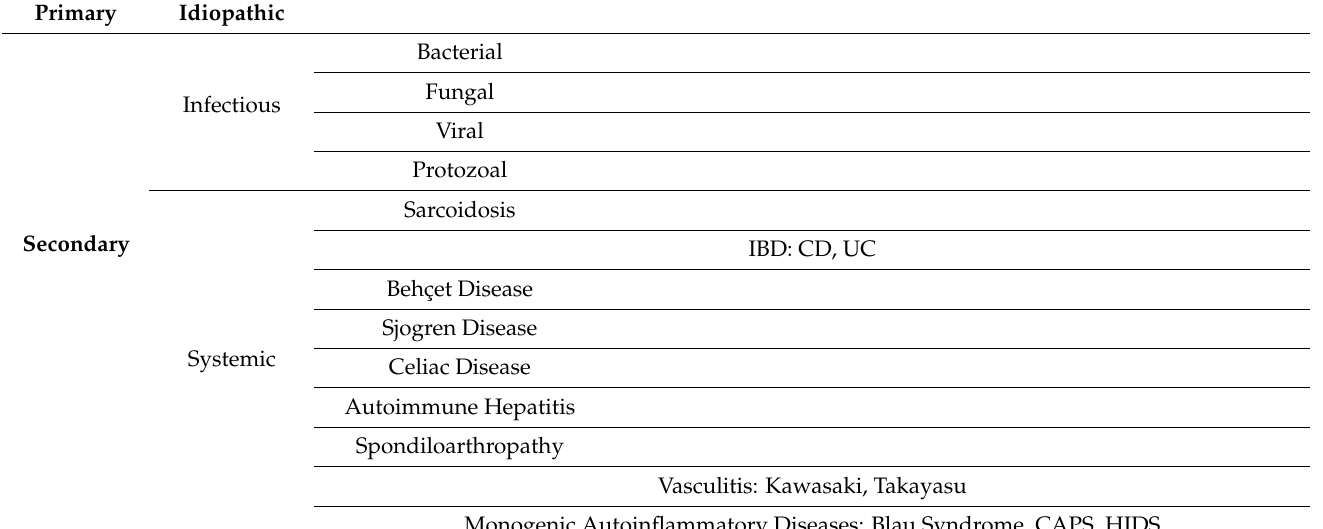
Table 1. Etiology of EN in children